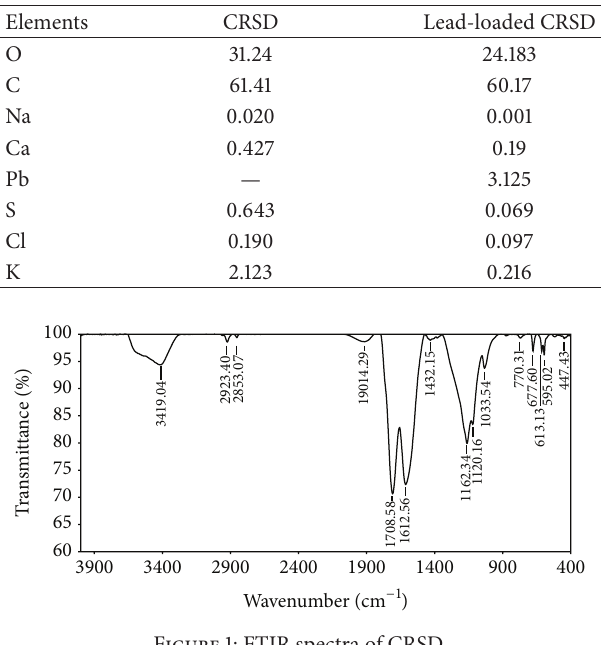
Table 2: XRF analysis on the CRSD before and after adsorption of lead (%).